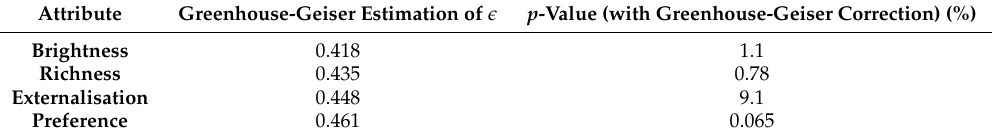
Table 4. A Greenhouse–Geiser estimation of (cid:101) and the results of a corrected one-way repeated measure ANOVA applied to the ratings given to each stimuli with respect to attribute. A p -value below 5% was considered